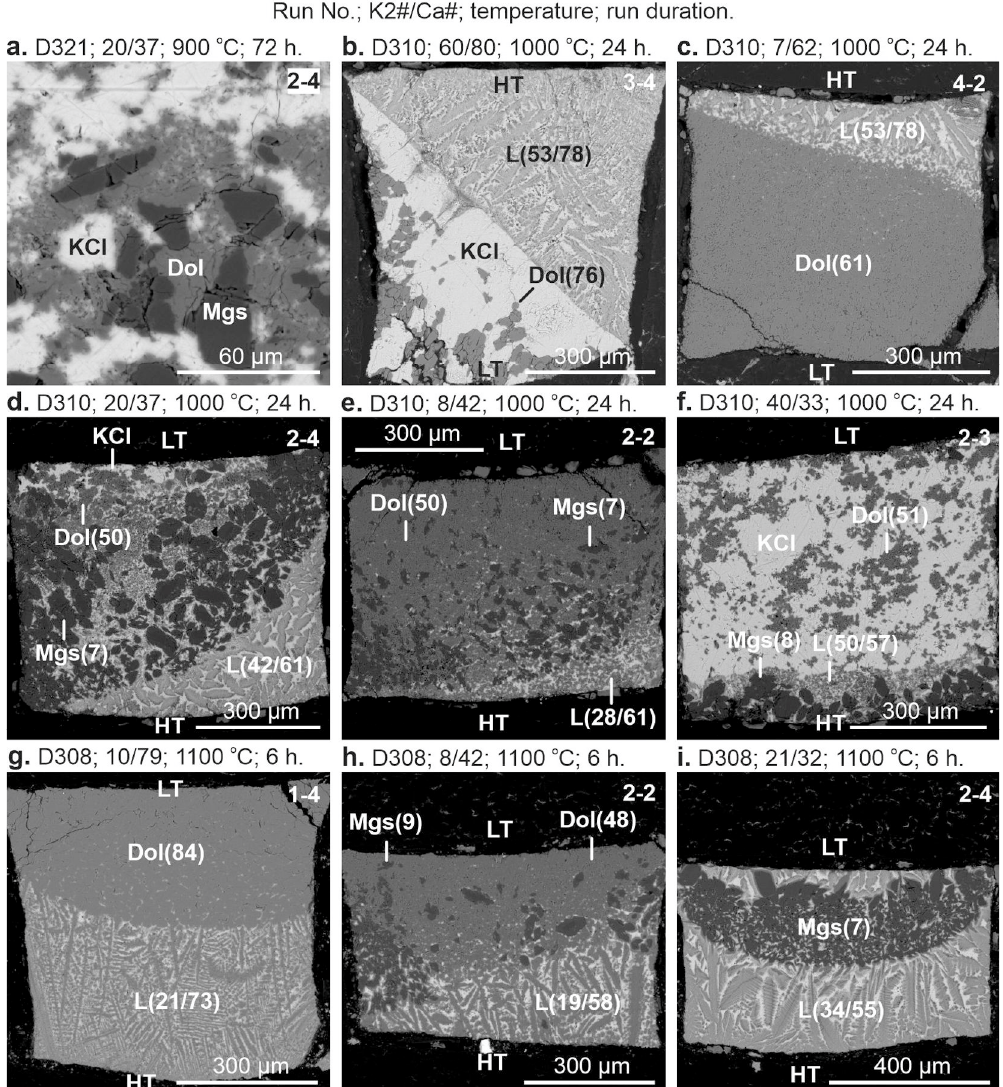
Figure 5. BSE images of sample cross-sections illustrating phase relations in the system KCl–CaCO 3 – MgCO 3 at 3 GPa and 900 ( a ), 1000 ( b – f ), and 1100 °C ( g – i ). HT—high-temperature side. LT—low- temperature side. The gravity vector is directed downward. The numbers in brackets after ‘Dol’ and ‘Mgs’ are the Ca# of the corresponding phase. The numbers in brackets after ‘L’ are K2#/Ca#. The numbers in the upper right corner of the images are sample numbers.